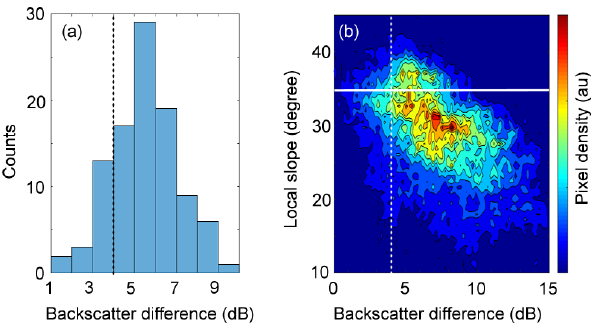
Figure 8. (a) Histogram of the mean relative brightness of avalanches compared to the surrounding area for manually mapped new avalanches of tsx(12-31 / 01-11) in the study area (red polygon, Fig. 1). (b) Relative brightness of the avalanche pixels in relation to the local slope angle. Lines indicate the thresholds for the backscat- ter difference (dashed) and the slope-dependent mask (solid).